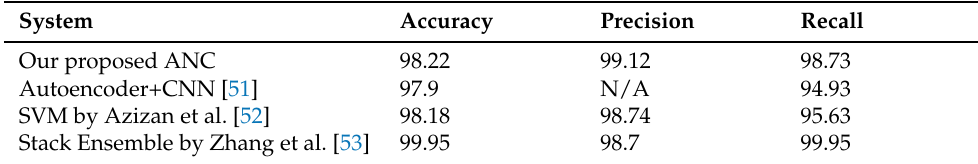
Table 15. Compare ANC with other research in CIC-IDS2017